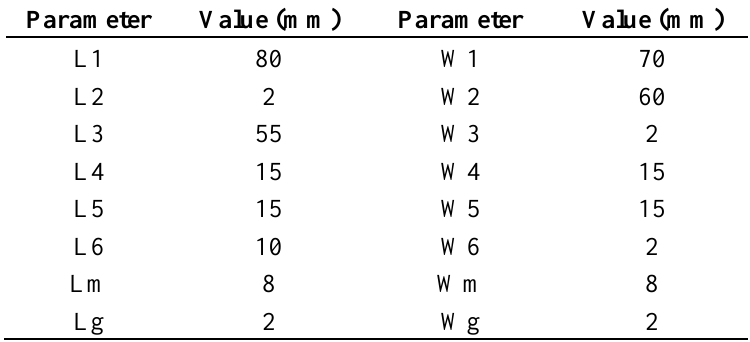
Table 1. Detail design specification of the proposed